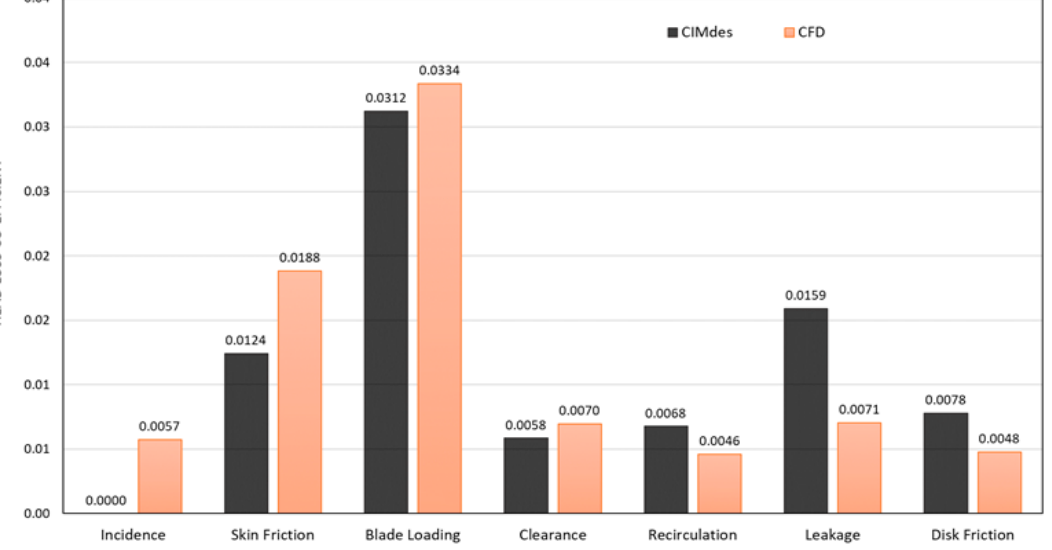
Figure 23. Loss comparison of 1D and 3D steady RANS solution for single-stage radial impeller.